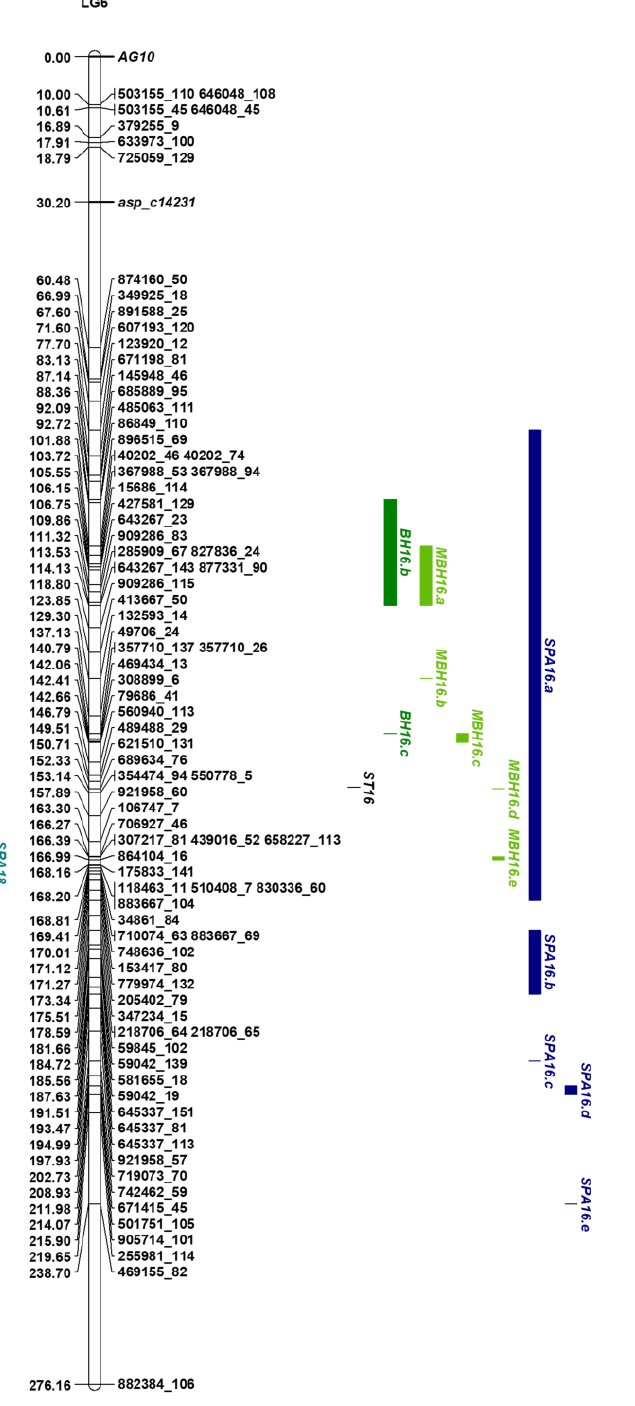
Figure 1. QTLs for morpho-agronomic traits identified in the asparagus F 1 population derived from the cross PS010 × WN124. The genetic distance is expressed in cM for each SNP. Stalk thickness (ST); branching height (BH); maximum first branching height (MBH); number of stems (NS); spears area (SPA). Only LGs with QTLs are shown.